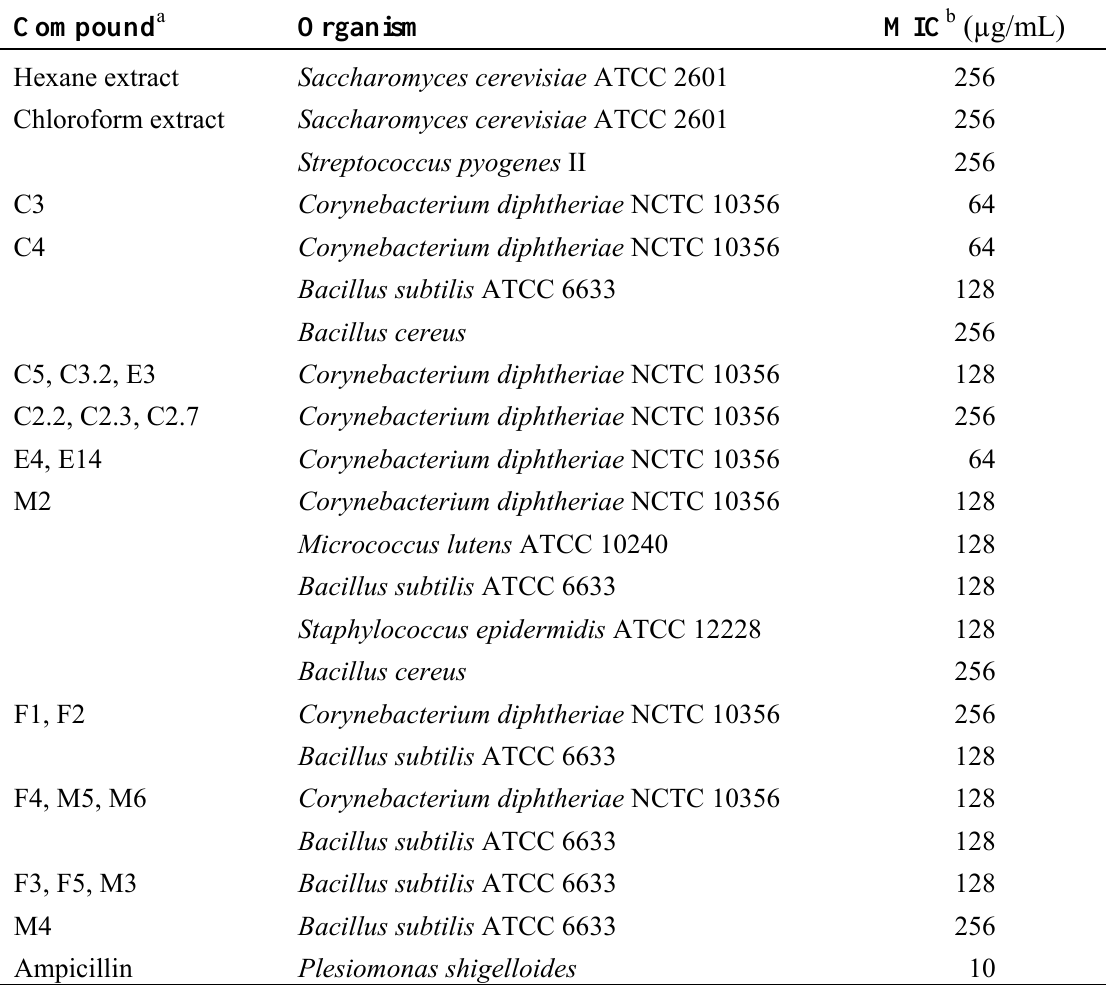
Table 2. Antimicrobial activity of S. acmella